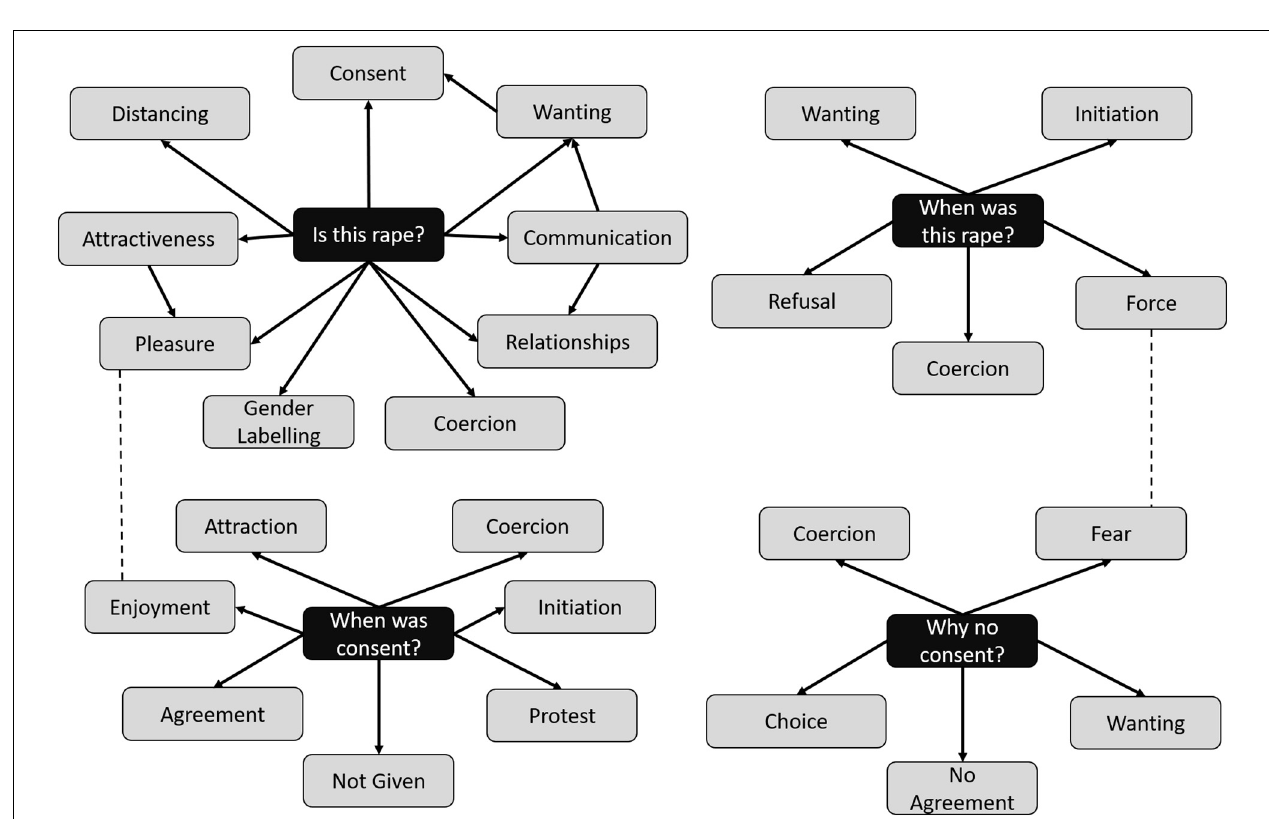
FIGURE 2 | Overall picture of the resulting themes for each of the questions, highlighting some significant overlap in what determines rape and consent.